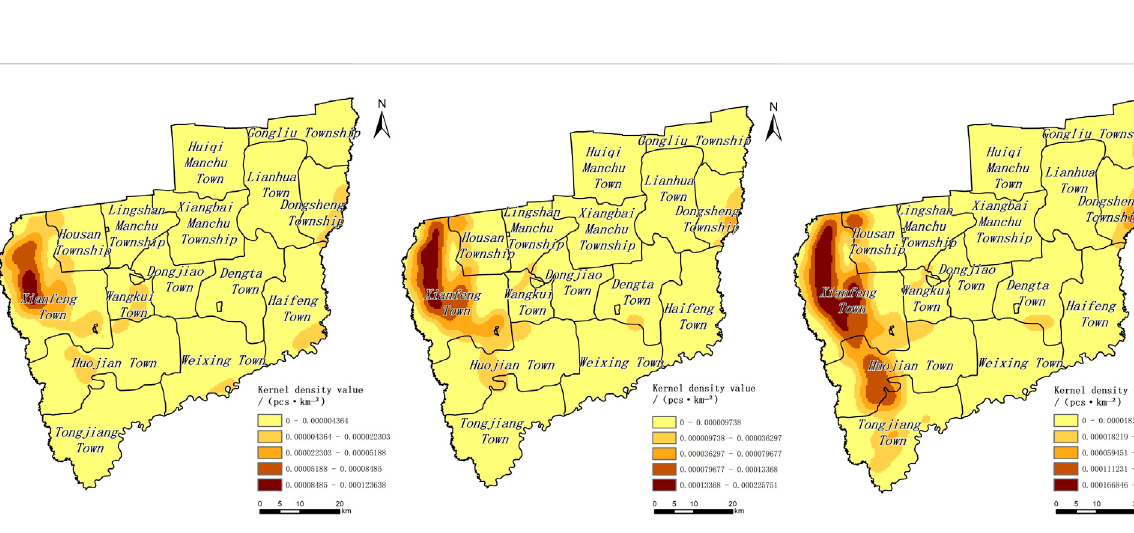
FIGURE 9 Spatial distribution characteristics and evolution of rice continuous-cropping